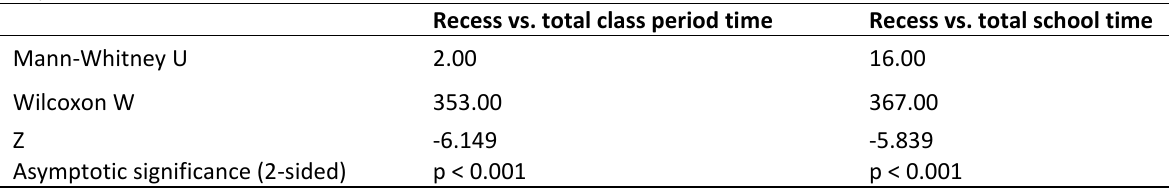
Table 2. Relationship physical activity level of recess and total class period time/school time (Mann-Whitney U test) Recess vs. total class period time Recess vs. total school time